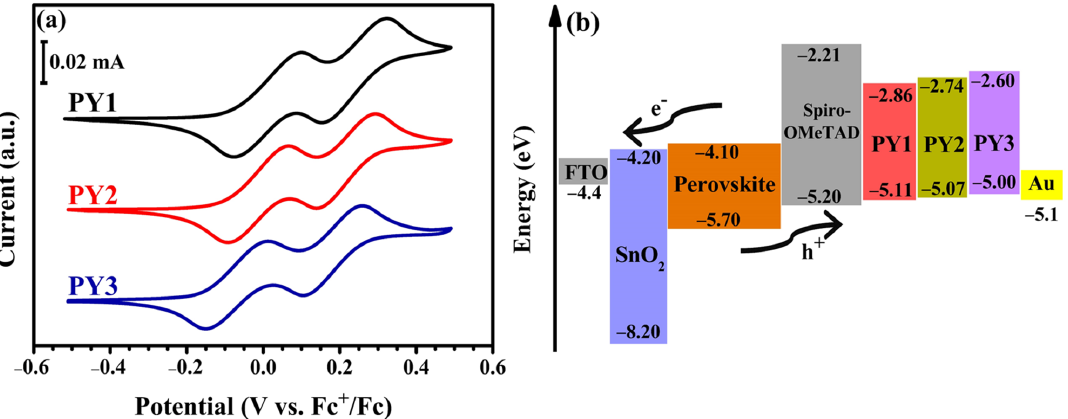
Figure 3. ( a ) CV of PY1 – PY3 in DCM (5 × 10 − 3 M); potentials vs. Fc + /Fc, 0.1 M Et 4 NBF 4 at a platinum electrode, scan rate 5 mV s − 1 . ( b ) Energy level diagram of each material in the PSCs.